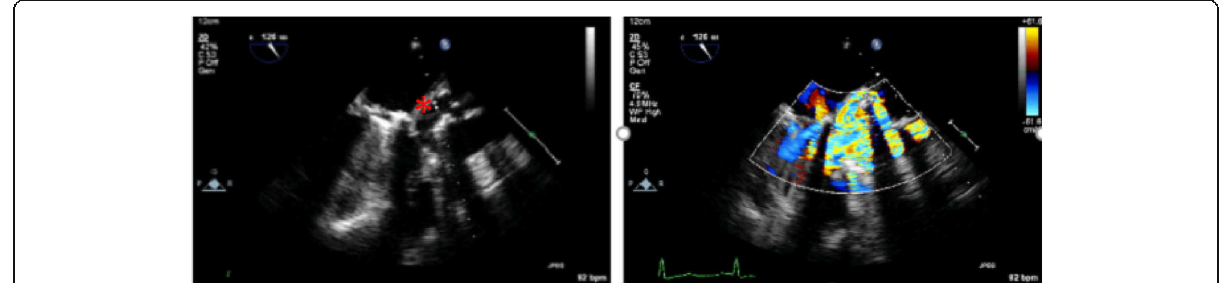
Fig. 1 TEE showing large aortic root abscess (ARA). The left image: ARA is seen at the posterior aspect of the aortic root as marked by *. The right image: considerable paravalvular leakage from the aorta to the left ventricular outflow